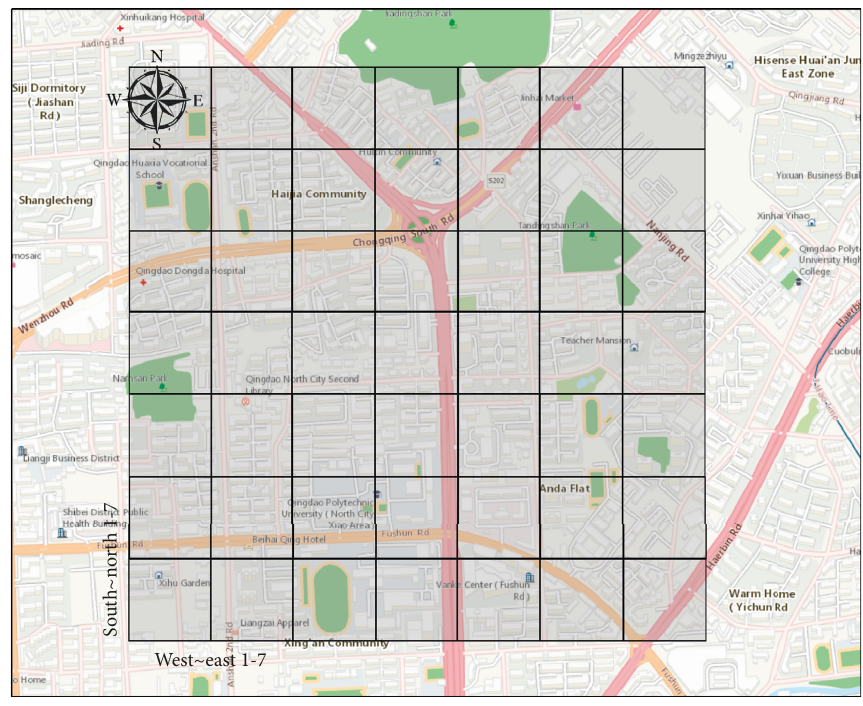
Figure 4: The area of the grid